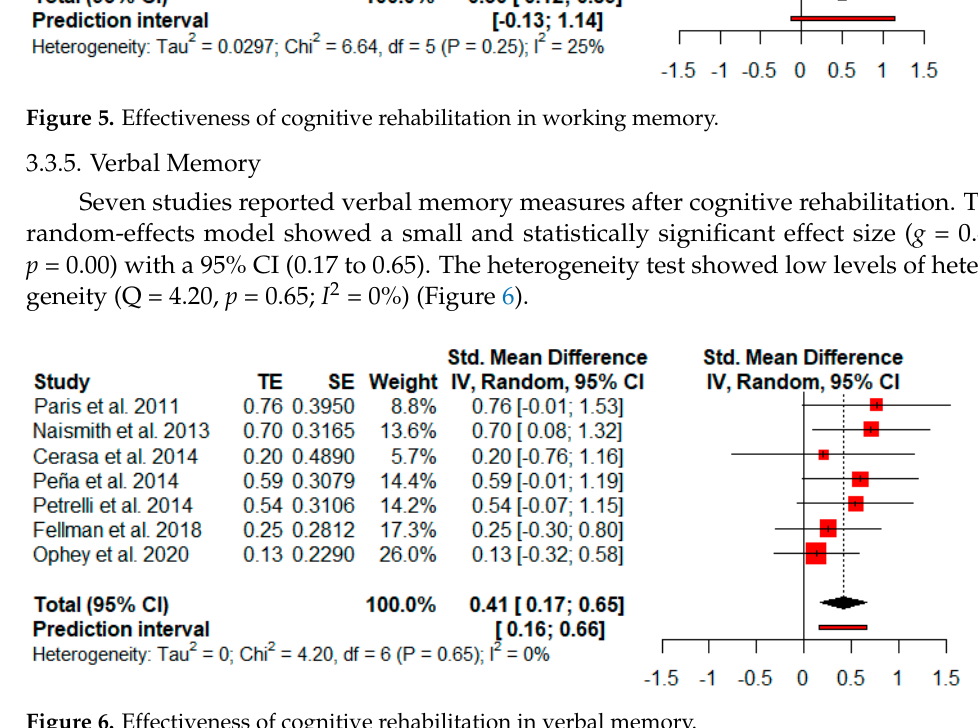
Figure 6. Effectiveness of cognitive rehabilitation in verbal Figure 6 . Effectiveness of cognitive rehabilitation in verbal memory. Figure 6 . Effectiveness of cognitive rehabilitation in verbal memory.